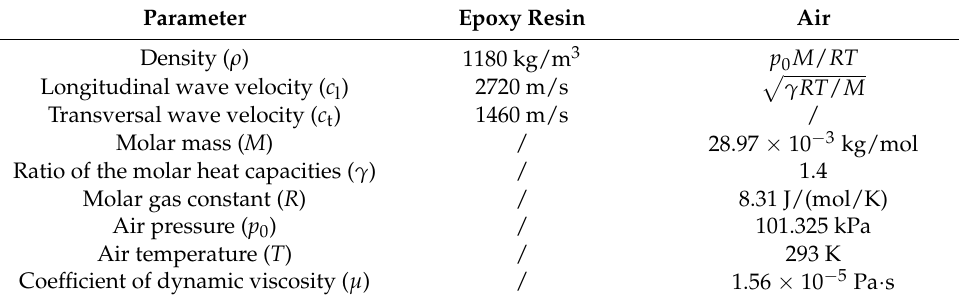
Table 2. Material parameters of numerical models.